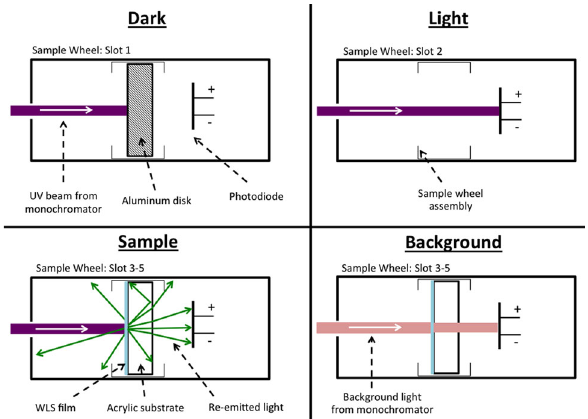
Fig. 7 A cartoon representation of the four types of photocurrent mea- surements